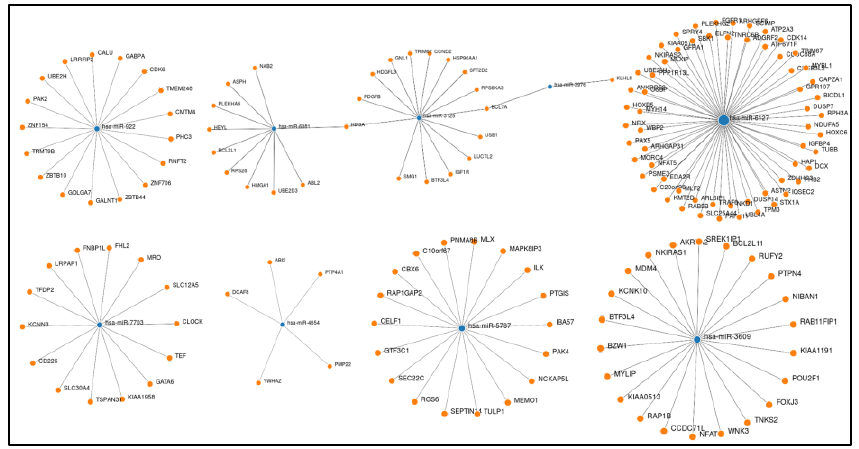
Figure 2. The node graphs of some dysregulated miRNA–target gene interaction associated with HbF level.